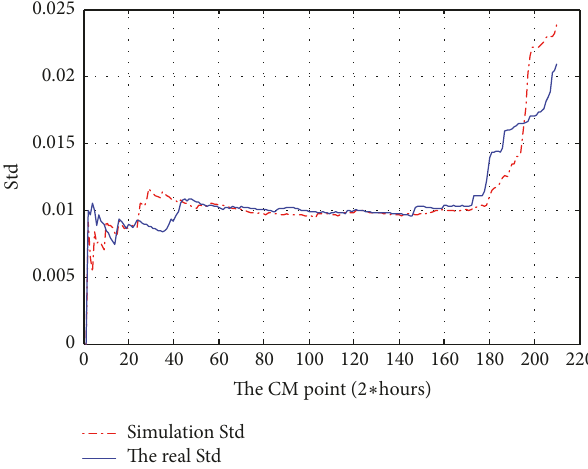
Figure 9: Comparison of the real Std and the simulation Std.